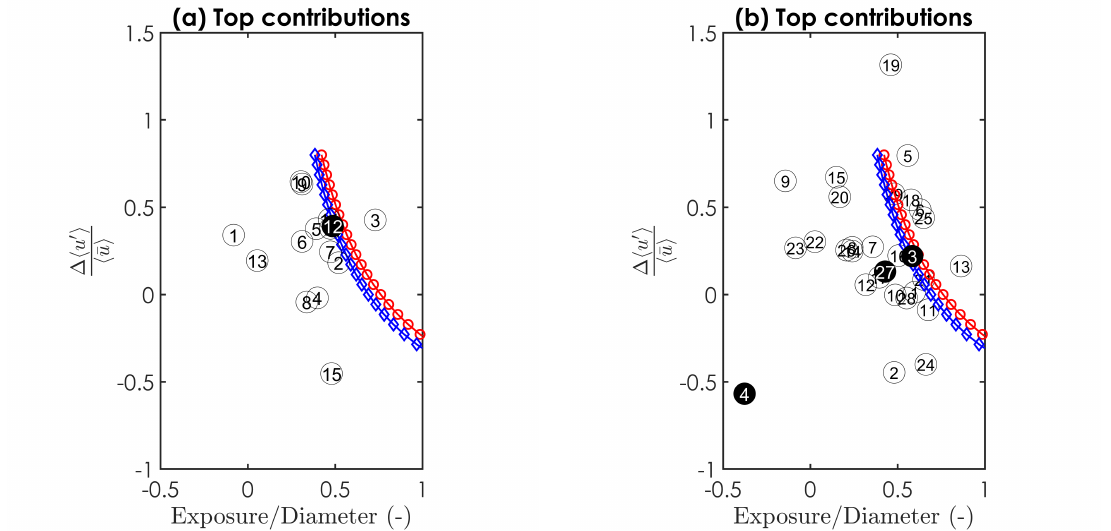
Figure 10. Ratio between longitudinal velocity fluctuations obtained with approach B and the longitudinal double-averaged velocities (averaged first in time and then in space-along the velocity reference level) as a function of the ratio between particle exposure and particle diameter for: ( a ) test T1; and ( b ) test T2. Each entrainment event corresponds to a numbered open circle. Curves corresponding to the theoretical exposure model proposed by Ferreira et al. [16] are preented as red circles model for sliding instability (Equation (6)) and as blue diamonds for rolling instability (Equation